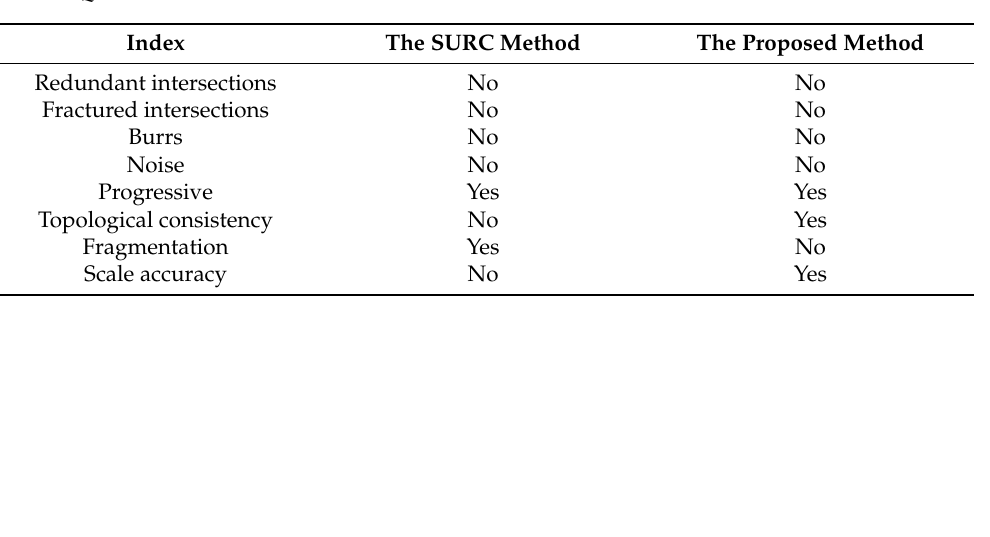
Table 3. Qualitative evaluation of the two